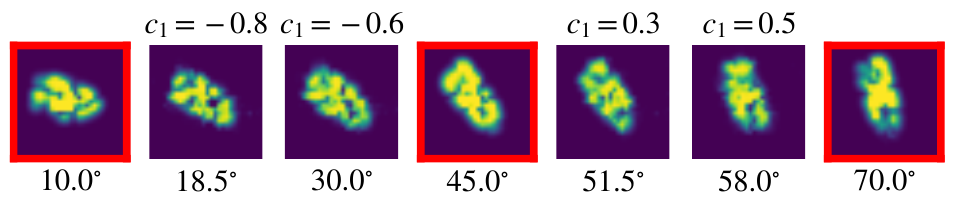
Figure 6. Real and synthesized SAR images for various rotation angles. The first , fourth , and seventh images (marked by red squares) are SAR images used for the training of the InfoGAN, while the second , third , fifth , and sixth images are the SAR images synthesized by the InfoGAN with the latent code values c 1 = − 0.8, − 0.6,0.3,0.5,